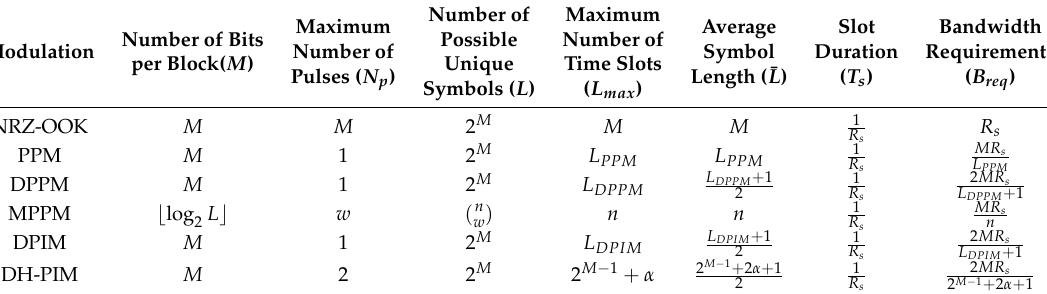
Table 1. Comparison of basic characteristics of digital pulse modulation